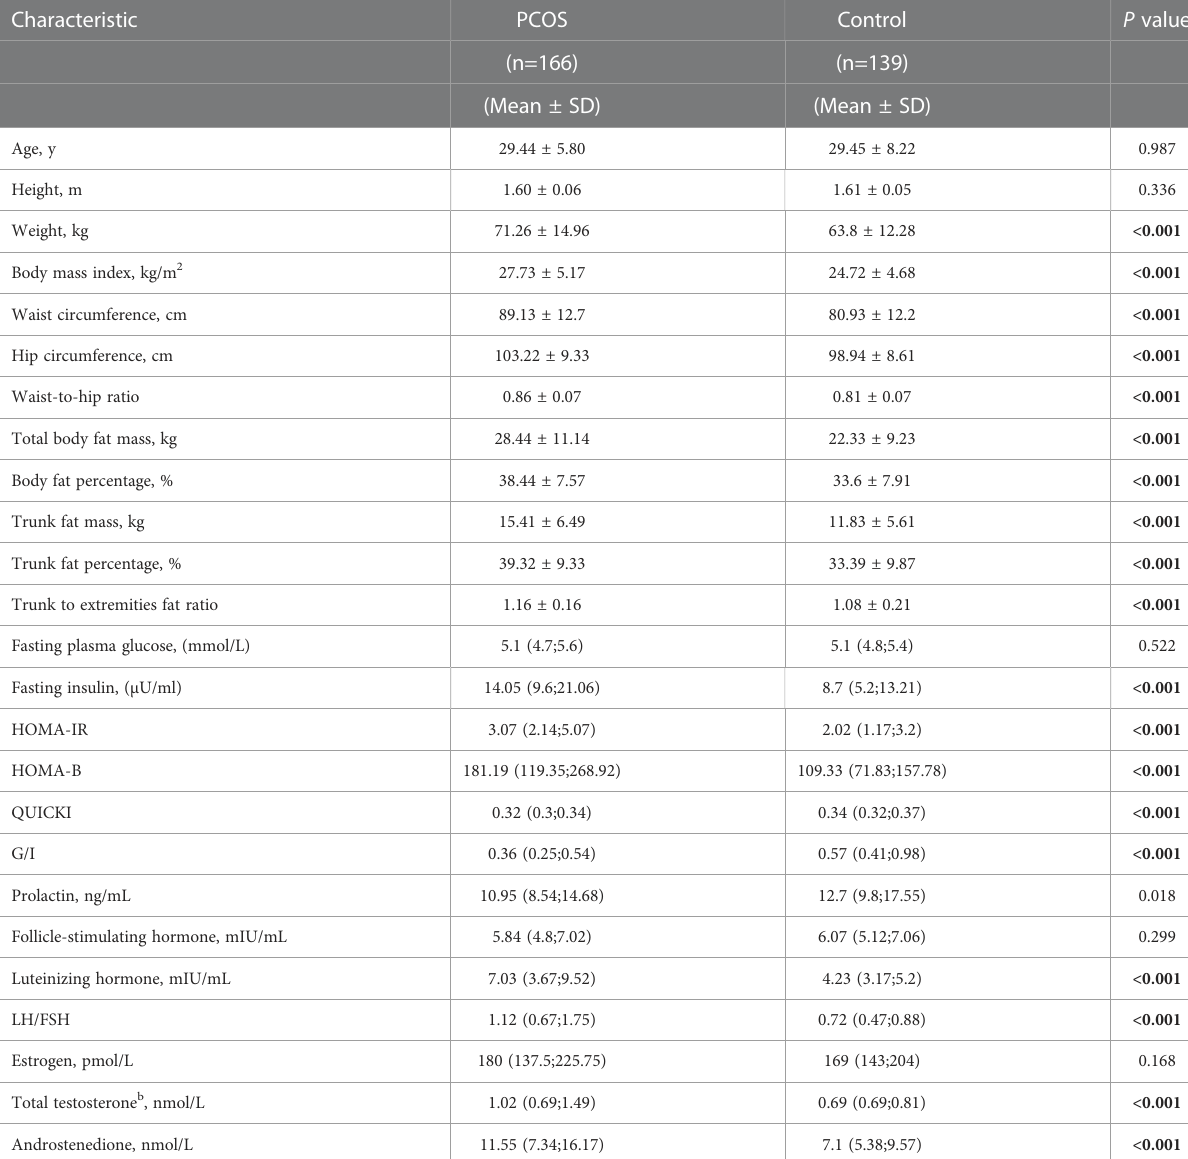
TABLE 1 Participant characteristics a